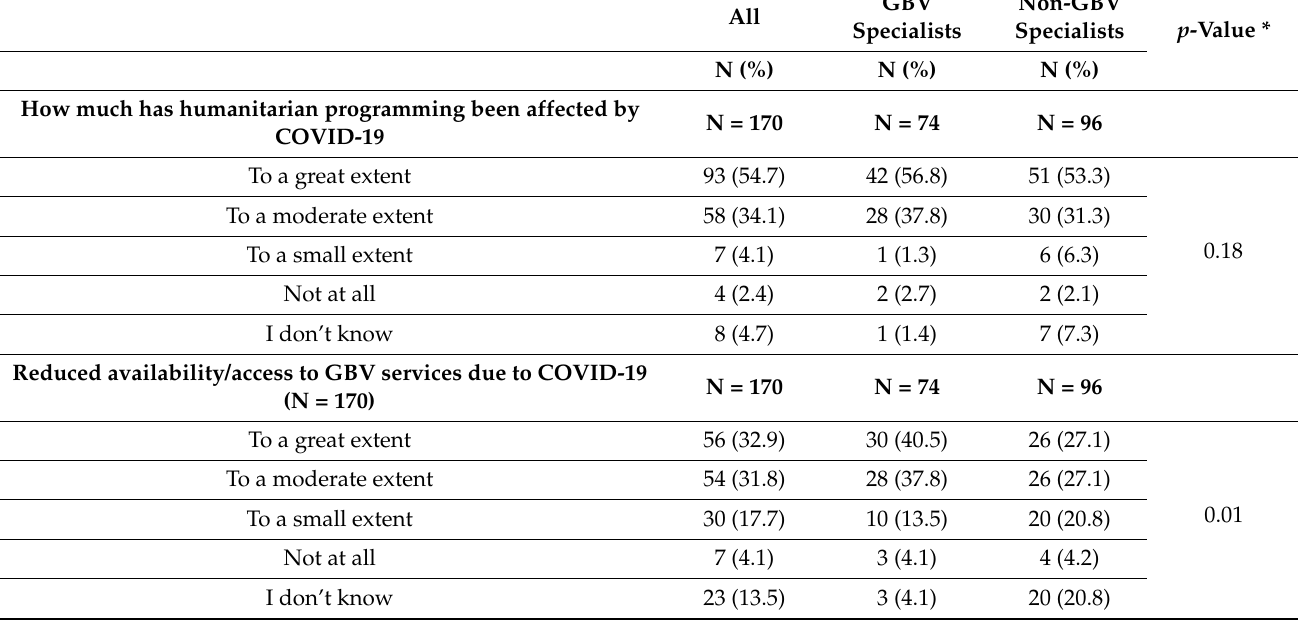
Table 4. Humanitarian programs & perceived GBV risk during